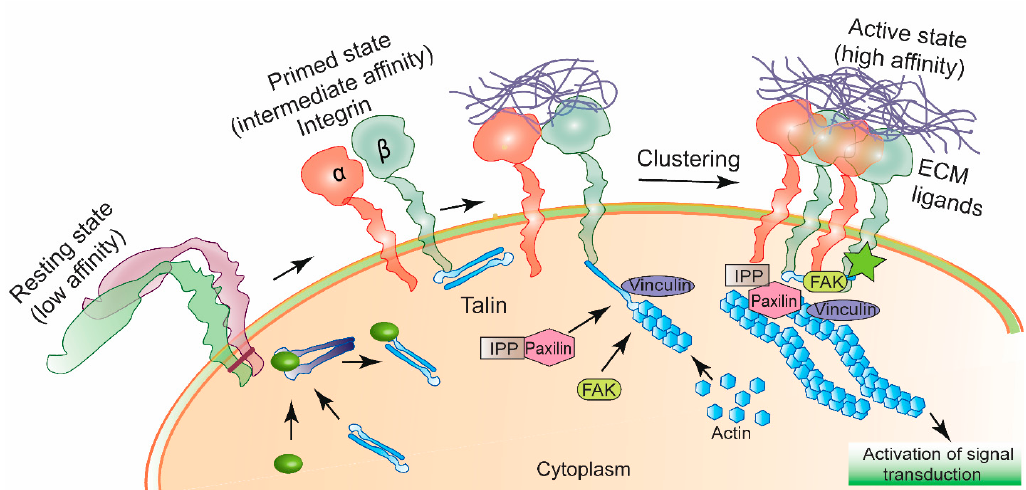
Figure 1. Schematic diagram of integrin activation. Integrins receptors when not in interaction with ligands from extracellular matrix (ECM) stay in an inactive conformation. Specific intracellular protein-induced conformational change in integrins allow them to bind certain ECM ligands. Ligand-bound integrins undergo clustering, gets attached to the actin cytoskeleton via a multiprotein complex of Paxilin, FAK (Focal Adhesion Kinase), IPP (ILK-parvin-PINCH) and Vinculin. Activated integrin participates to control signal transduction for maintaining cellular motility, proliferation and invasion [11].